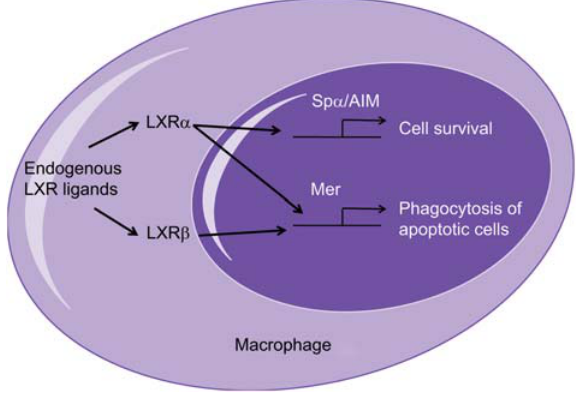
Figure 1 Endogenous ligand-mediated LXR activation in macro- phages promotes survival and